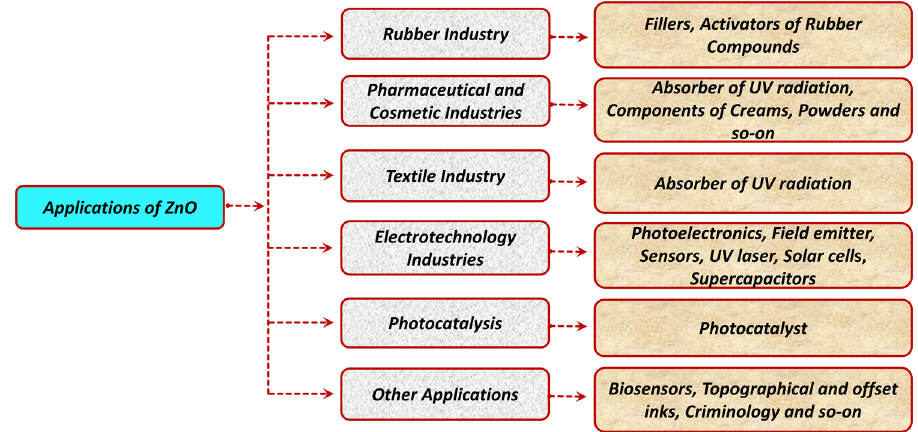
Figure 18: Schematic representation of applications of ZnO in di ff erent fi